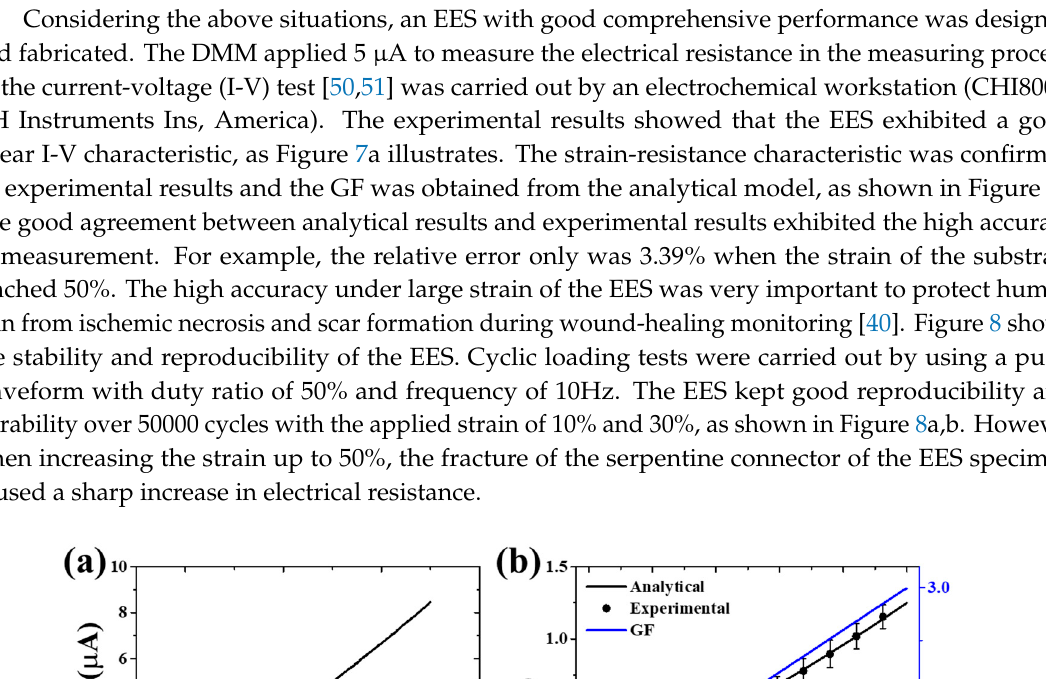
Figure 6. The deformation of the EES under stretching strains 0% ( a ), 25% ( b ) and 50% ( c ), compared with results obtained by FEA.